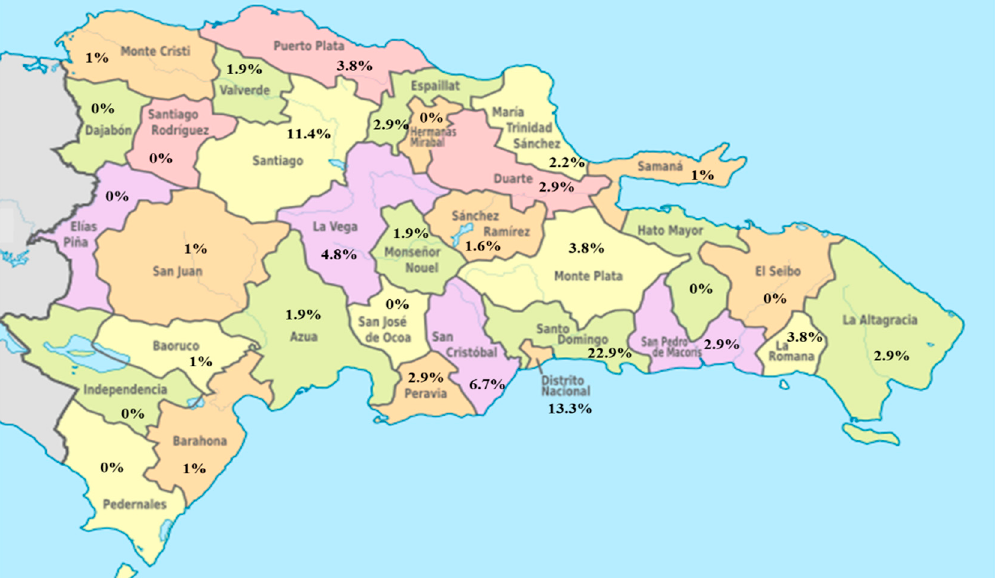
Figure 1. Distribution of the study sample by provinces or regions .